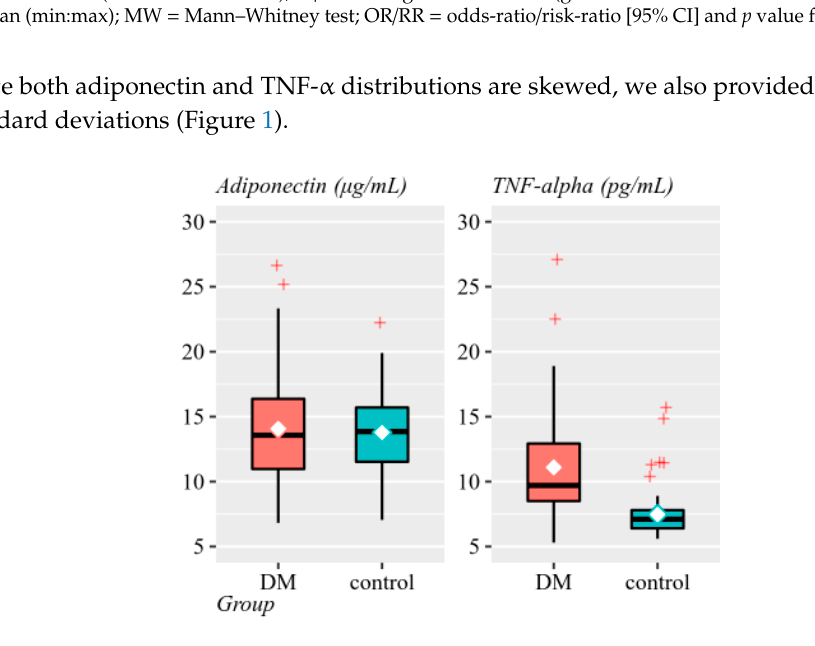
Figure 1. Adiponectin ( µ g / mL) and TNF- α (pg / mL) values by groups ( (cid:95) mean, — median, +